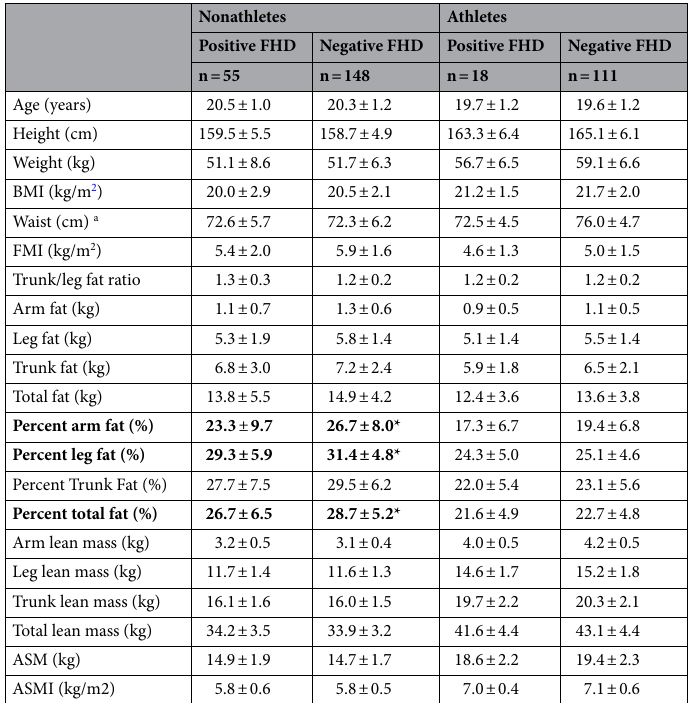
Table 1. Body composition of young Japanese women in the presence and absence of family history of type 2 diabetes (FHD). Mean ± SD. a n = 48 and 64 in nonathletes and n = 9 and 32 in athletes with positive and negative family history, respectively. ASM: appendicular skeletal muscle mass, ASMI: ASM index, BMI: body mass index, FMI: fat mass index. Bold letters indicate * p < 0.05.